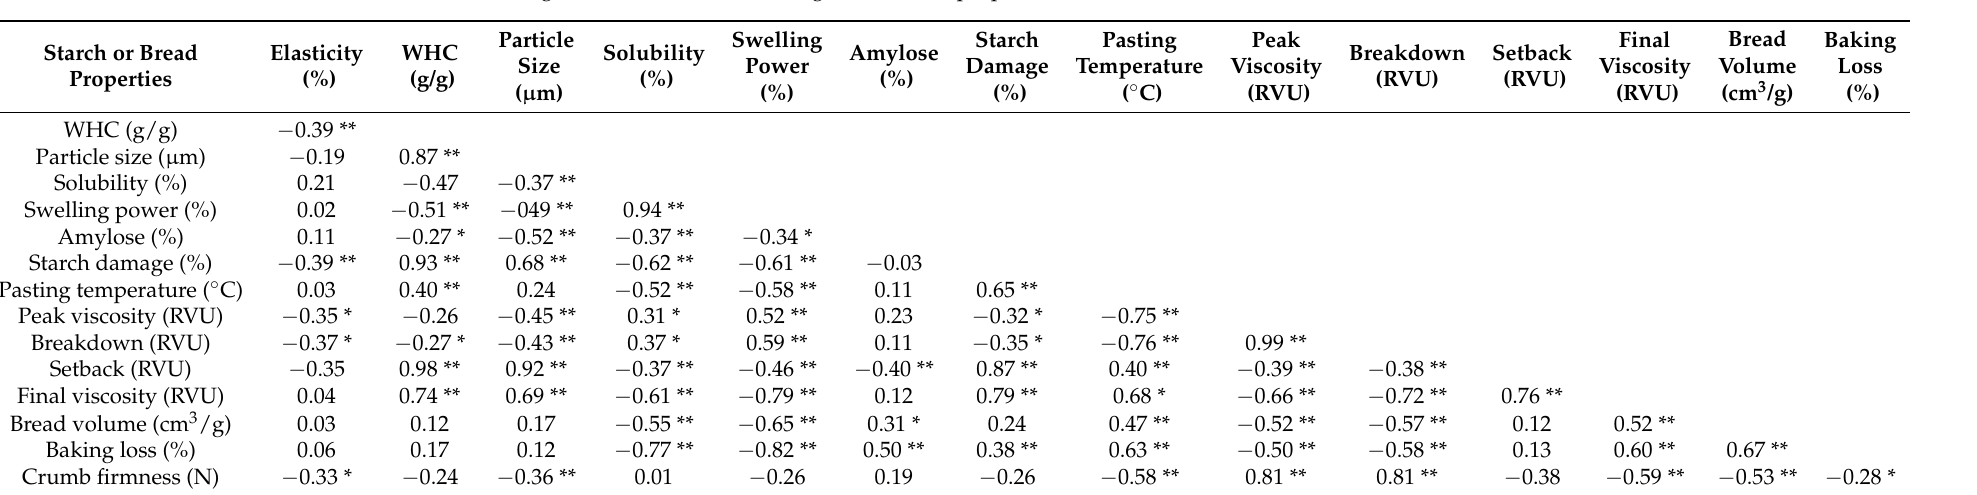
Table 2. Significant correlations among starch/flour properties and ohmic-heated bread